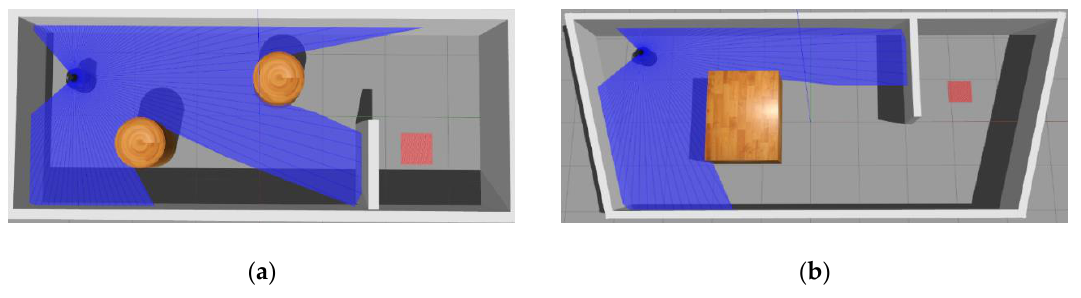
Figure 8. Two test maps (T-MAPs): ( a ) T-MAP 1 and ( b ) T-MAP 2.